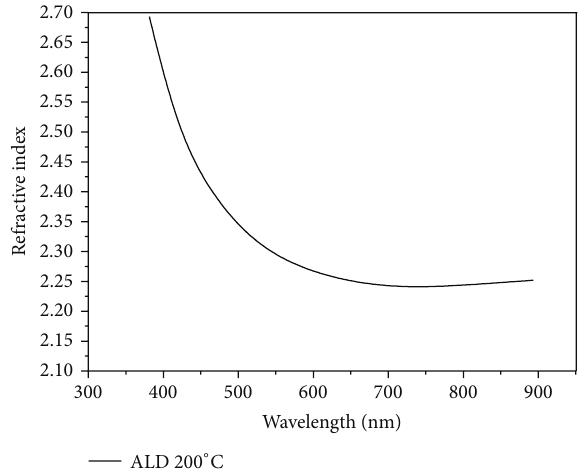
Figure 9: Refractive index as function of wavelength for TiO 2 thin film grown at 200 ∘ C.